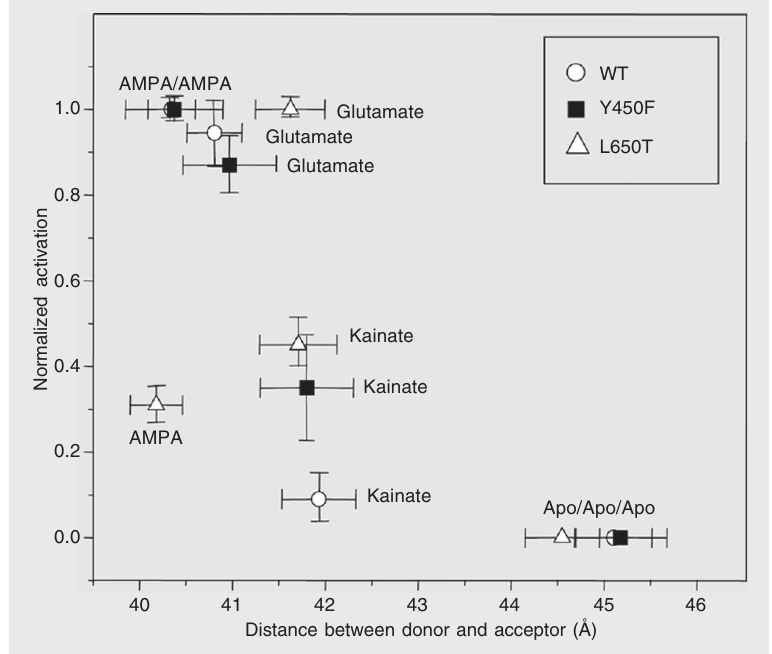
Figure 3. Distance between N-terminus/residue T394 and residue S652 as determined by fluorescence resonance energy transfer for the GluR2-S1S2 wild type (WT) and L650T and Y450F mutants plotted as a function of extent of activation for the apo and α -amino-3- hydroxy-5-methyl-4-isoxazolepropionic acid (AMPA)-, glutamate-, and kainate-bound states. Reproduced from Ref. 36 ( Biochemistry 2007; 46: 1343-1349) with permission. Copyright 2007 American Chemical